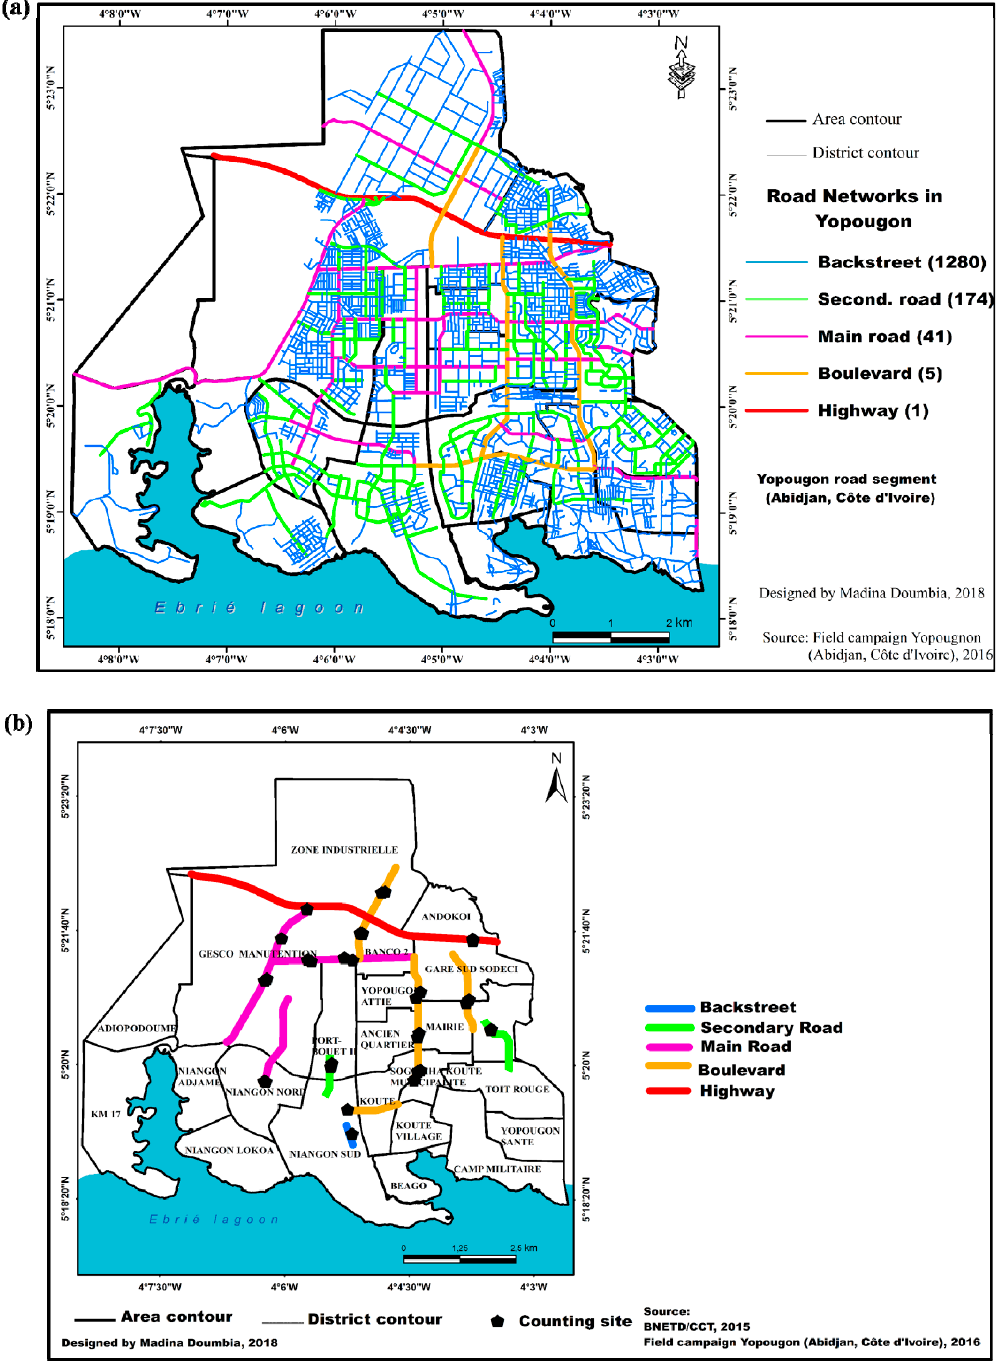
Figure 3. ( a ) Different road types of road network in Yopougon. Red line represents the highway, blue line is for backstreet, pink line is the main road, green and orange are the secondary road and boulevard, respectively. Number of road segments of each road type are in brackets; ( b ) Location of counting point of vehicle fleet composition over several road type in Yopougon.